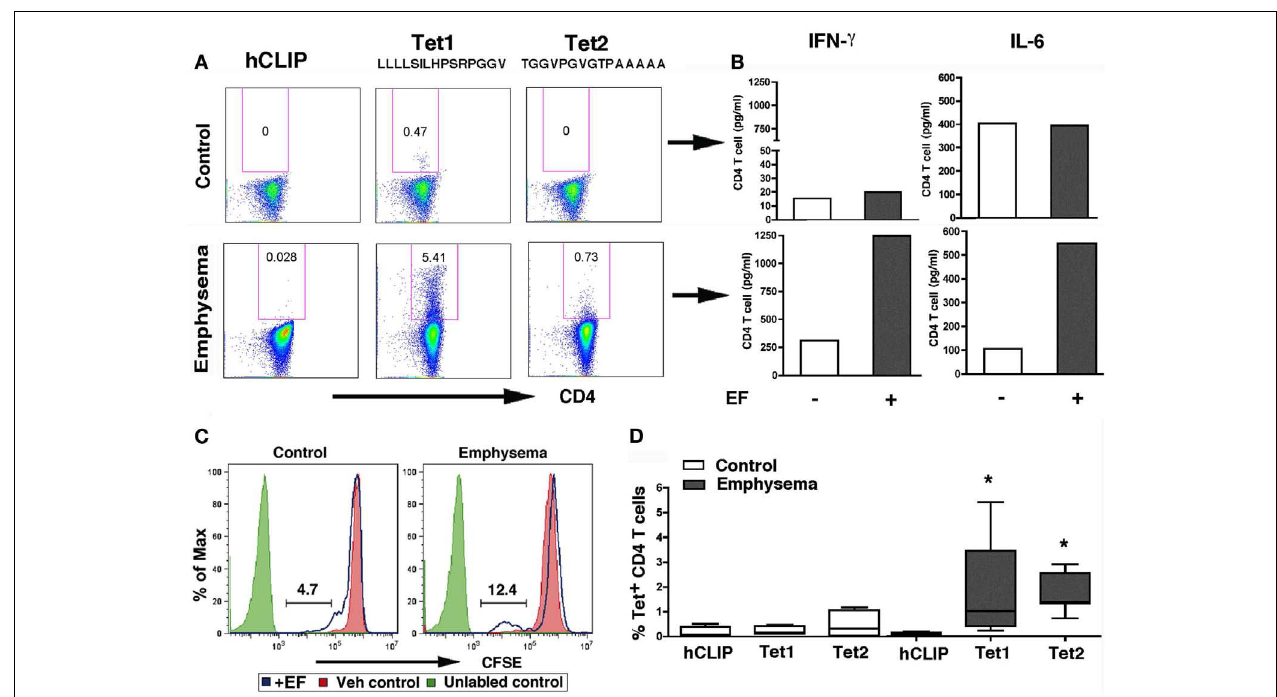
corresponding patients. Cytokine concentrations were measured by LINCOplex. (C) Representative histograms of CD4 + T cells CFSE-labeled isolated from PBMC of control or emphysema volunteers cultured overnight in the presence (blue lines) or absence (red filled lines) of elastin fragments (30 µ g/ml). Unlabeled control cells are shown in solid green lines. (D) Cumulative relative % abundance of tetramer positive CD4 + T cells in controls ( n = 5) and emphysema ( n = 7) for tetramer 1 and 2 as well as a non-specific tetramer hCLIP as described in Figure 6A